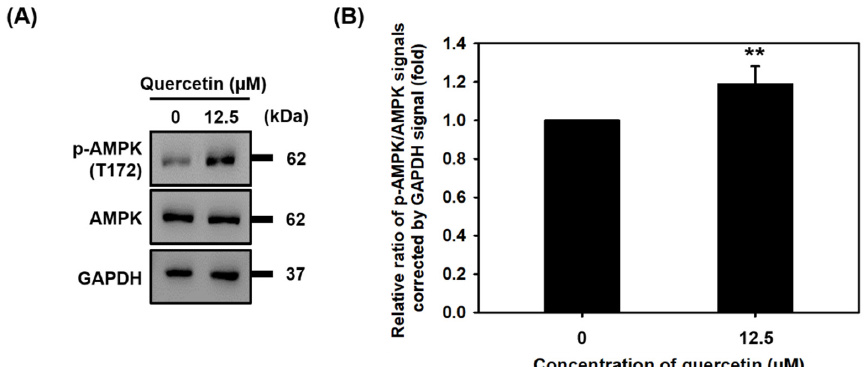
Figure 5 . Quercetin induced the phosphorylation of AMPK. C2C12 cells were grown to 80% conflu- ency density in a 24-well plate, each well treated with or without quercetin (0, 12.5 μ M) and cultured in DMEM medium containing 2% horse serum to promote cell differentiation for 7 days. ( A ) Western blot analysis was used to study relative protein expression of AMPK and p-AMPK, with GAPDH used as internal control. ( B ) Bar graph quantitated relative protein of expression of p- AMPK and AMPK. Data are expressed as the mean ± SD based on three independent biological repeats ( n = 3). We found a significant difference between treatment group and controls ** p < 0.01.